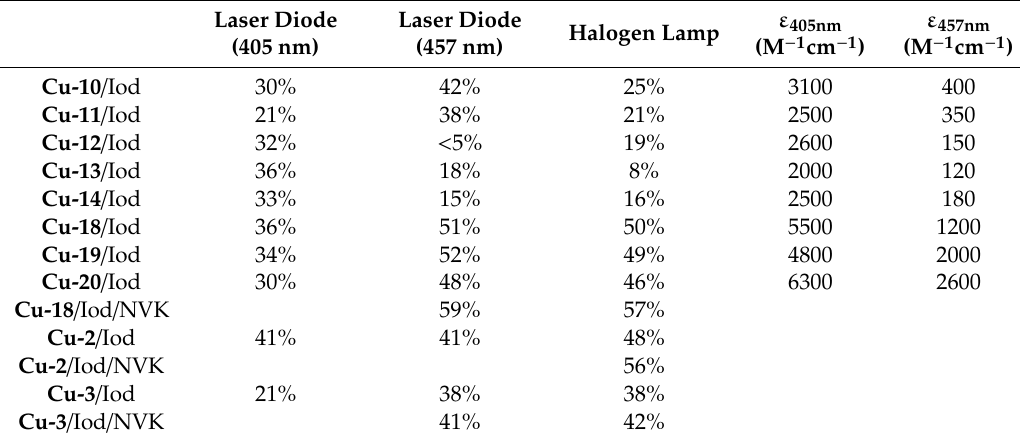
Table 2. TMPTA conversions determined in laminate for two-component systems Cu-x(x = 11–20) / Iod (0.2% / 2% w / w ) and three-component systems Cu-x(x = 2,3,18) / Iod / NVK (0.2% / 2% / 3% w / w / w ) upon irradiation at di ff erent wavelengths for 500 s and light absorption properties at the emission wavelength of the light sources (extracted from the work in